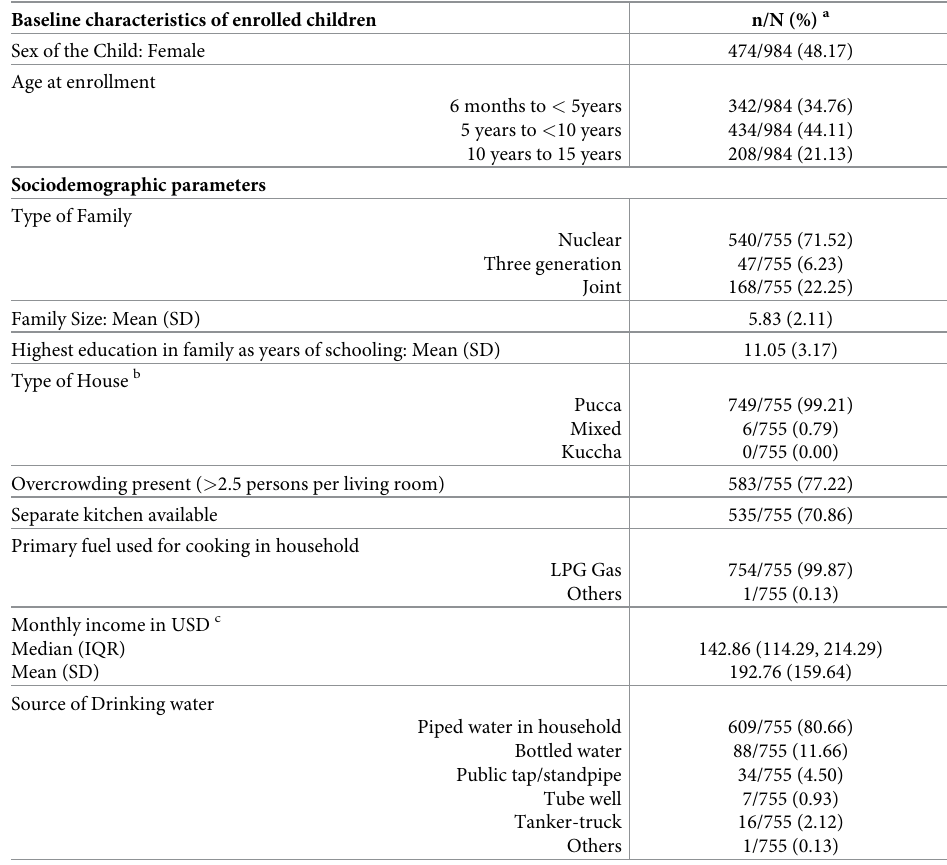
Table 1. Characteristics of the study